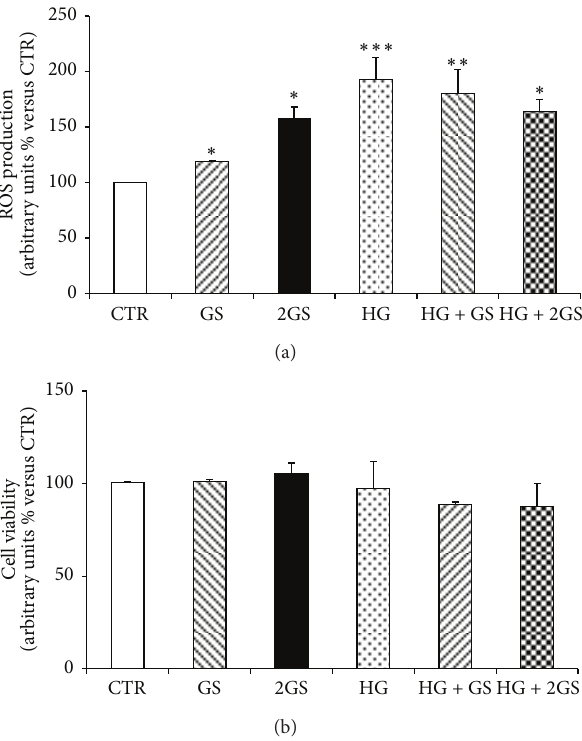
Figure 1: GS and HG increase intracellular ROS without affecting GLUTag cell viability. After 5-day treatment in the presence of stan- dard medium (CTR) or high glucose concentration (25 mmol/L) (HG) in presence of different concentrations of glycated serum (400 [GS] and 800 nmol/L [2GS]), ROS intracellular production (a) and cell viability (b) were assessed. Values shown indicate the percentage of absorbance compared to CTR. Data are expressed as the mean ± SE of 𝑛 = 5 (ROS release) or 𝑛 = 3 (cell viability) independent experiments. ∗ 𝑃 < 0.05 , ∗∗ 𝑃 < 0.01 , and ∗∗∗ 𝑃 < 0.001 versus